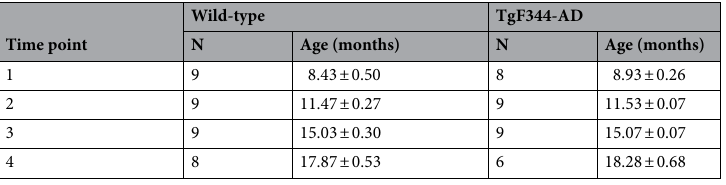
Table 1. Longitudinal MRI/MRS experiment. Sample sizes and age. Number of MRS datasets acquired per group, time point, and age (median ± interquartile range).